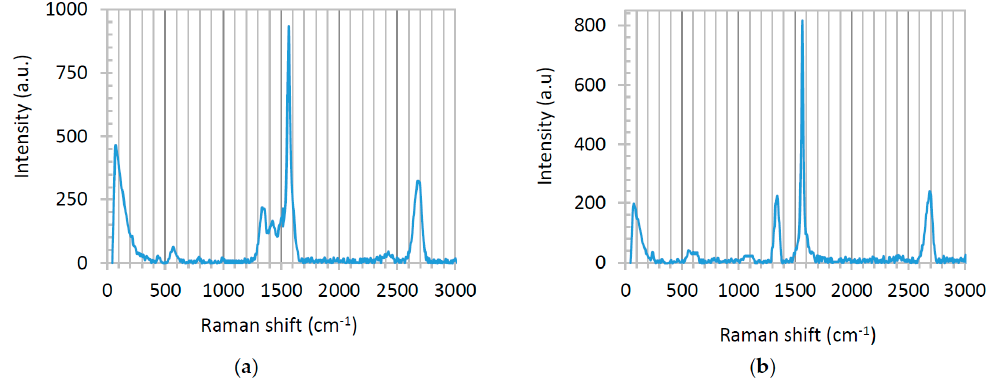
Figure 6. Raman spectra of graphene ‐ TiO 2 thin films, deposited from precursor solution with TS:GD volume ratio of 1:4: ( a ) spin ‐ SVPT; and ( b ) SVASC films annealed at 150 °C. volume ratio of 1:4: ( a ) spin-SVPT; and ( b ) SVASC films annealed at 150 ◦